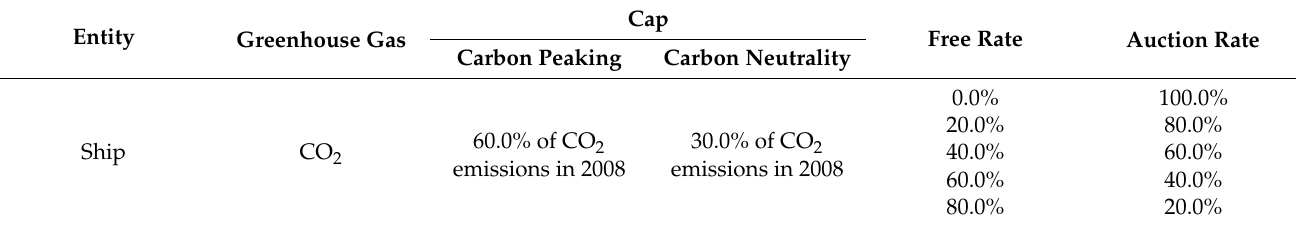
Table 1. The key elements of METS